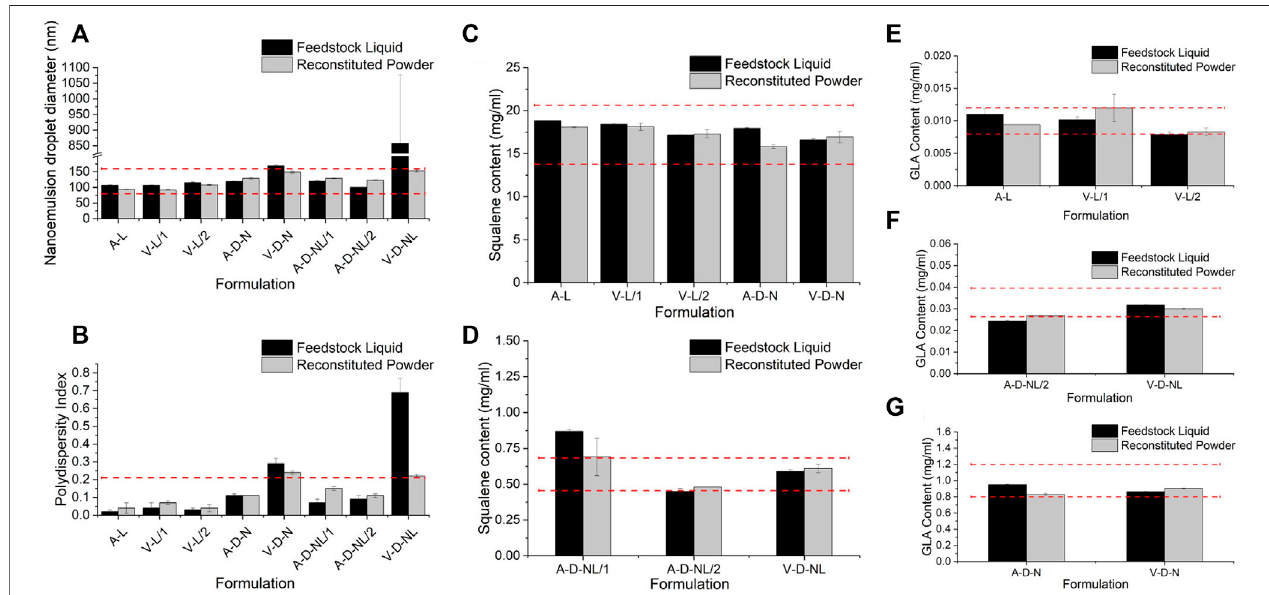
FIGURE 4 | Comparison of the physicochemical properties before and after spray drying of the lots manufactured for the mouse model in terms of (A) nanoemulsion droplet diameter, (B) polydispersity index, (C,D) squalene content, and (E – G) GLA content. Measurements of the feedstock liquid are given in black, whereasmeasurementsofthereconstitutedpowder aregiven in grey,foreach lot.Resultsarereported as the mean ± standard deviation. Thetargetrangefor each lot is demonstrated by the red dashed lines. Target range was a nanoemulsion droplet diameter measured as 120 ± 40 nm, polydispersity index < 0.2, and squalene and GLA content ± 20% of the target feedstock concentration. Nomenclature: V – Vaccine; A – Adjuvant; L – Liquid; D – Dry powder; N – Nose; NL – Nose and Lung.